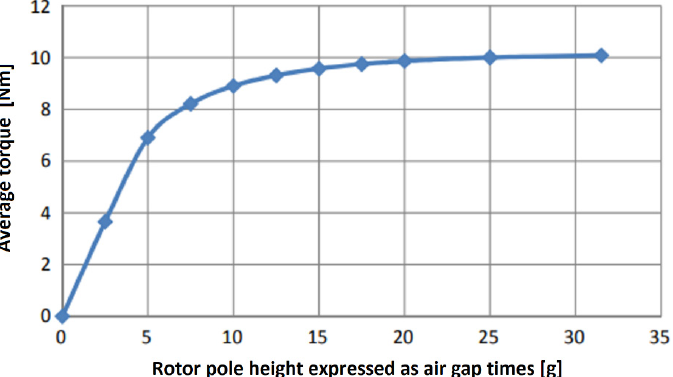
Figure 17. Average motor torque as a function of rotor pole height expressed in millimeters.